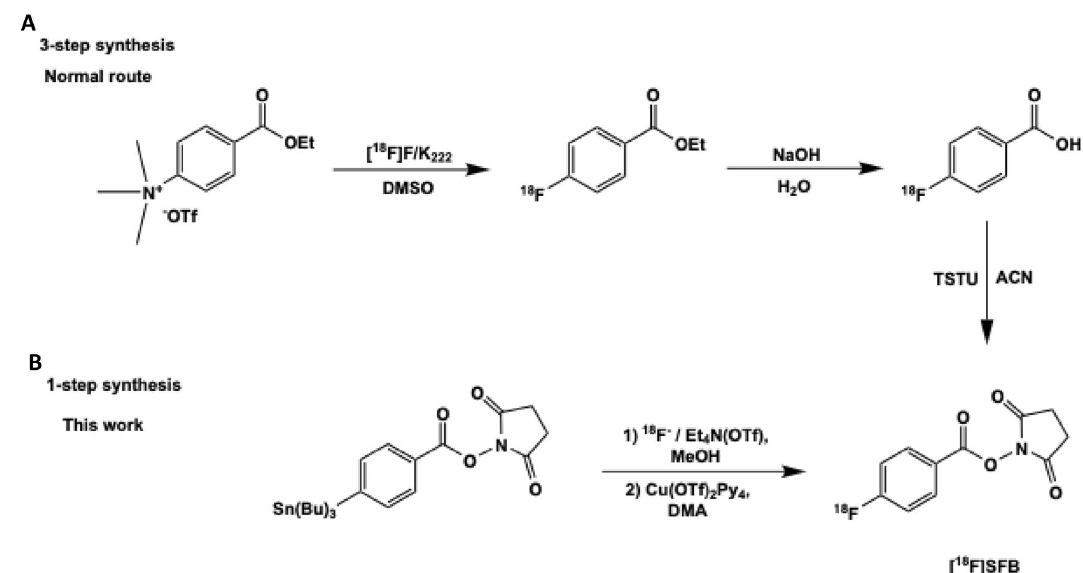
Figure 2. Standard 3-step procedure ( A ) and novel one-step method ( B ) of the synthesis of [ 18